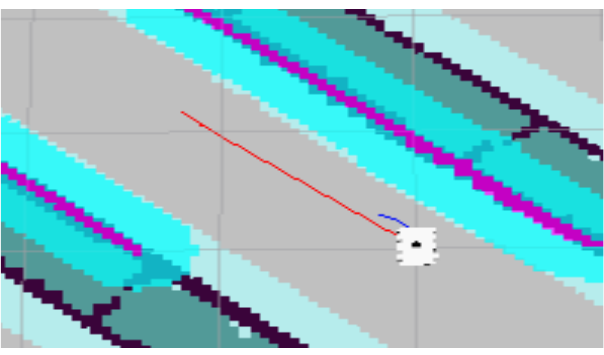
Figure 10. Navigation enlarged map.